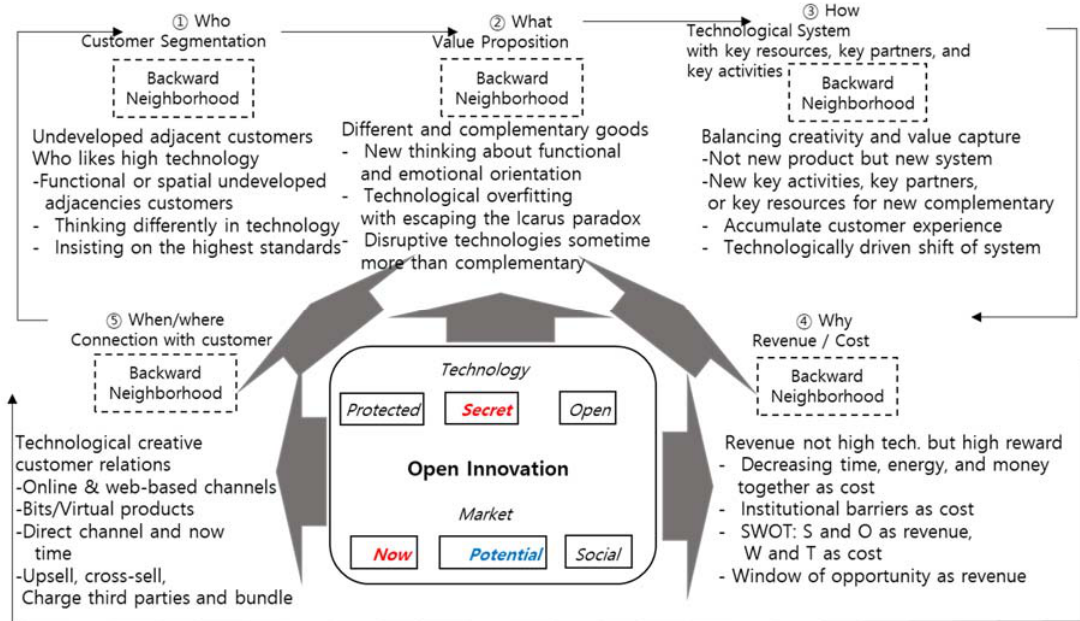
Figure 6. Cultivating backward neighborhood rectangle concept model for engineer-centered business model innovation.